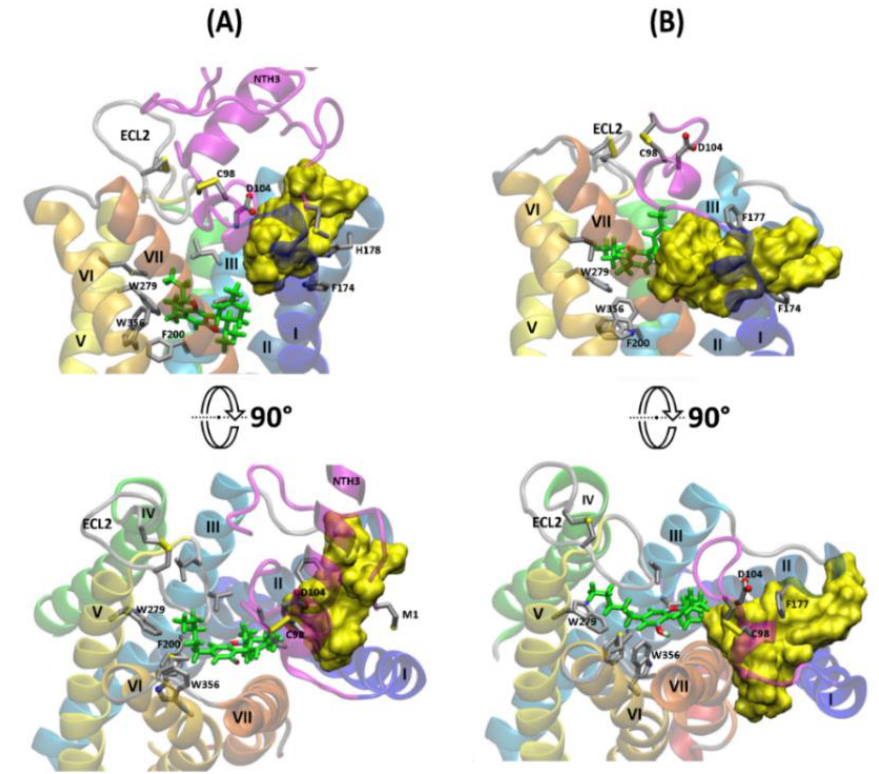
Figure 11. Comparison of CBD binding modes (yellow surface for all poses) obtained after 1 µ s of MD simulations for ( A ) WT CB 1 R (with whole N-terminus), five CBD poses superimposed; and for ( B ) CB 1 R with truncated N-terminus—four CBD poses (two for ∆ -88 and two for ∆ -98 CB 1 R). All poses were superimposed using receptor structure as a reference. Orthosteric agonist, THC, is shown in green.